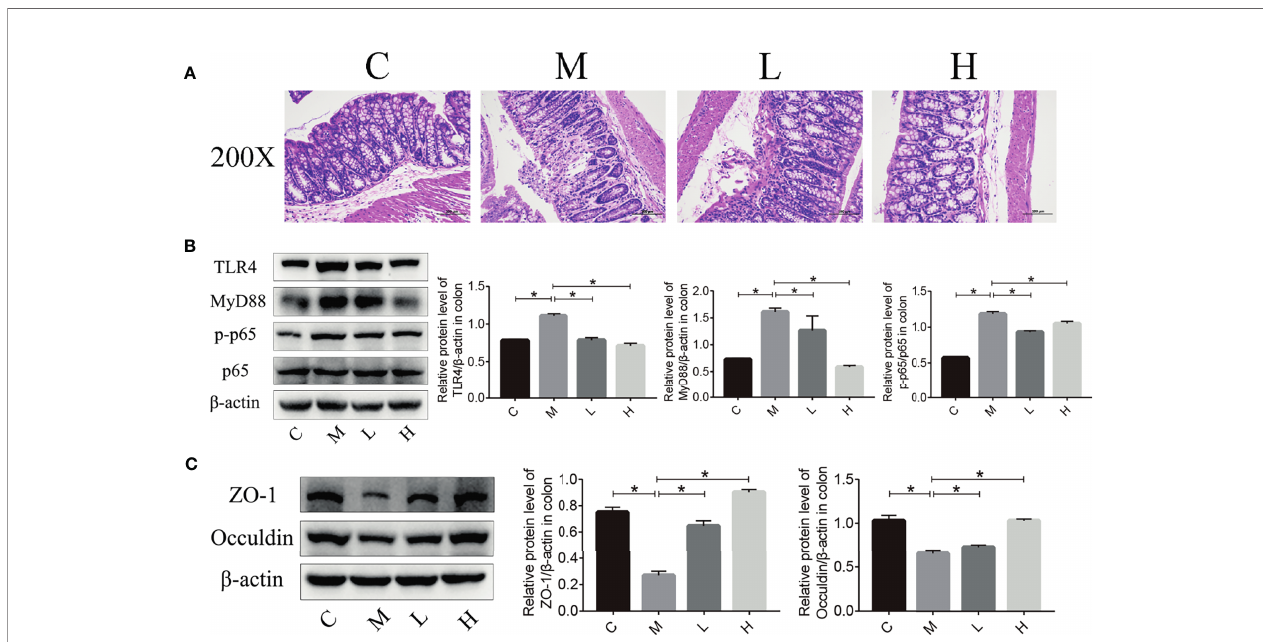
FIGURE 6 | The probiotic combination alleviated colonic in fl ammation and decreased tight junction protein expression in SAMP8 mice. (A) HE staining of the colon. (B) The effect of the probiotic combination on the expression levels of TLR4, MyD88, p-p65 and p65 in the colon. (C) The effect of the probiotic combination on the expression levels of ZO-1 and Occuldin in the colon. C, control group (n = 4); M, model group (n = 4); L, low-dose probiotics group (n = 4); H, high-dose probiotics group (n = 4). Data are presented as the means ± SD. *p <